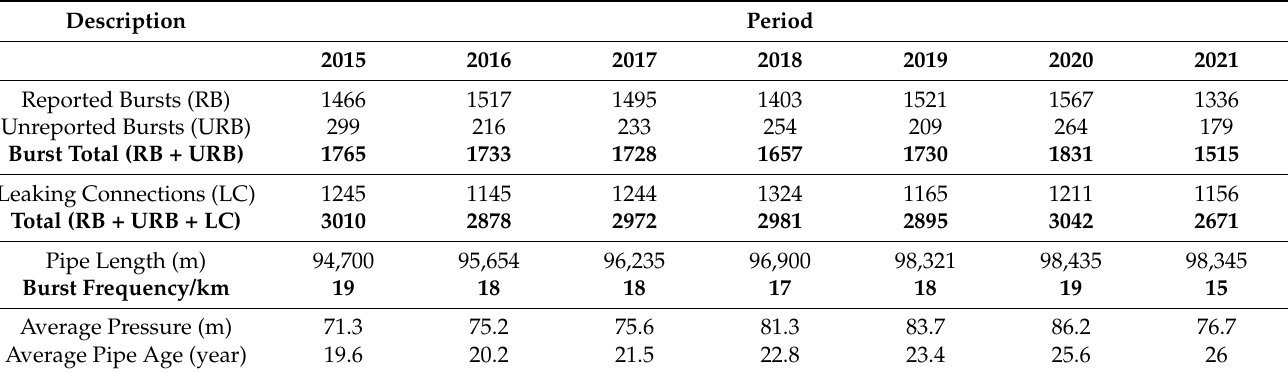
Table 4. Linear repair and maintenance data (2015–2021).